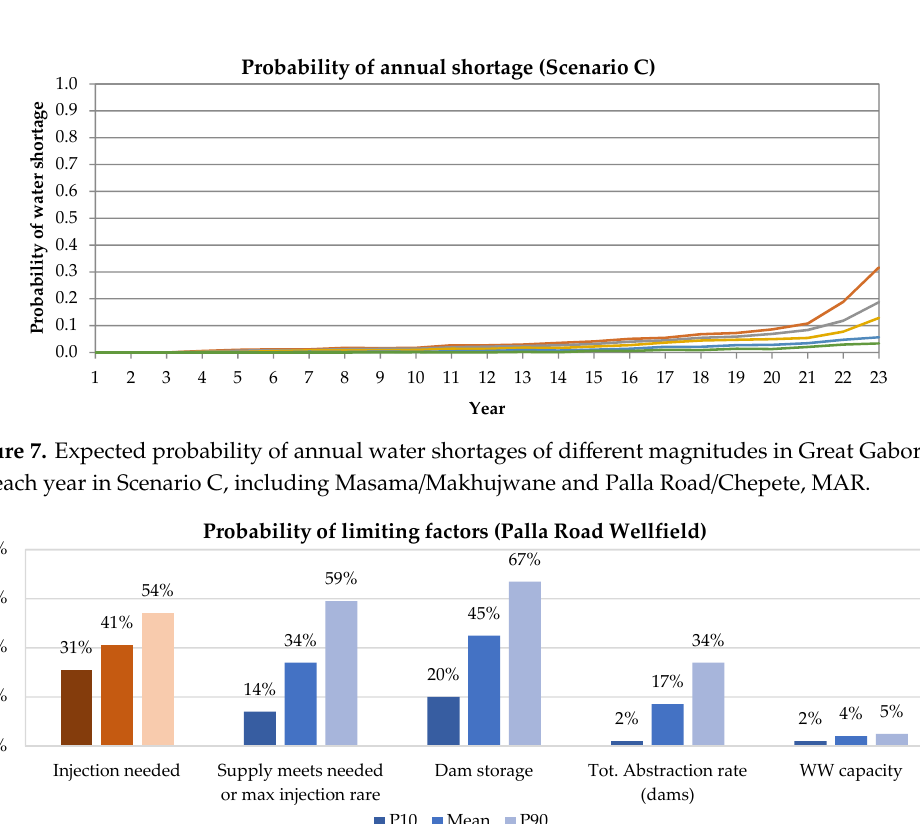
Figure 8. Factors limiting the injection at Palla Road Wellfield, Scenario C.